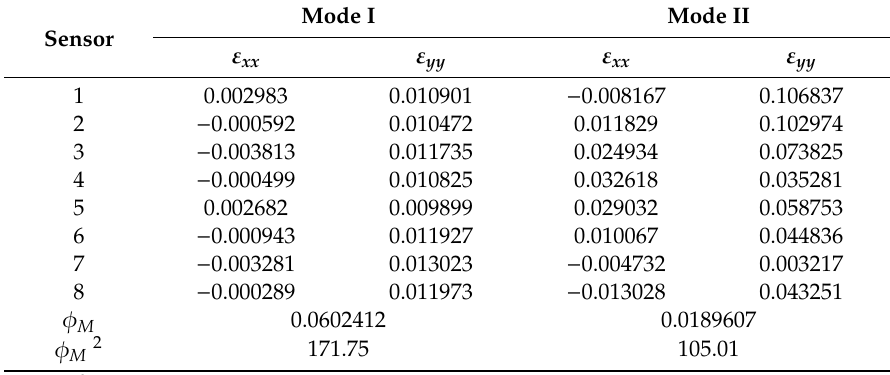
Table 5. Measured strains (unit µ ) of the eight sensors in composite plate with a crack (NI 9237). Sensor